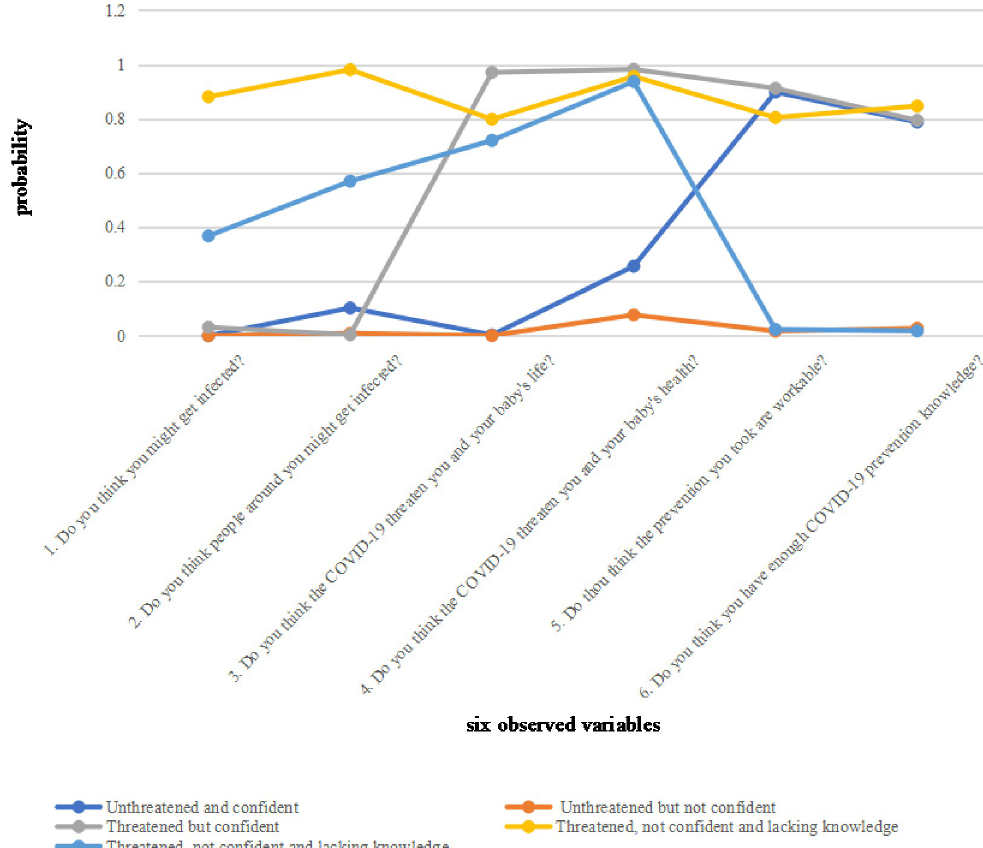
Fig 1. Laten class analysis profile pilot: The conditional probability distribution of six observed variables by membership.